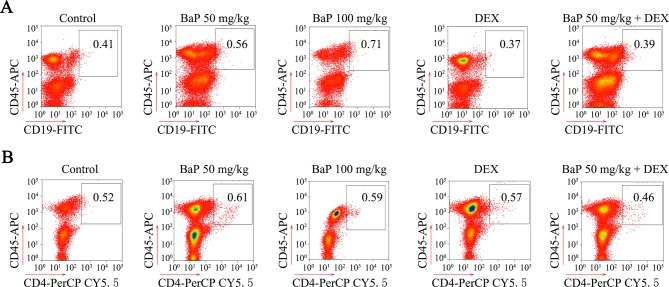
Analysis of B cells and T cells in benzo(a)pyrene (BaP)-induced lung cancer.(A) The expression of Cd19 in Cd45+ leukocytes sorted from lung cancer tumor samples was analyzed by flow cytometry. (B) The expression of Cd4 was analyzed in Cd45+ leukocytes by flow cytometry.